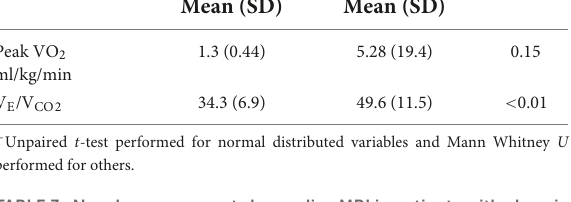
TABLE 2 Baseline cardiopulmonary exercise tests between those with and without resting pulmonary hypertension.